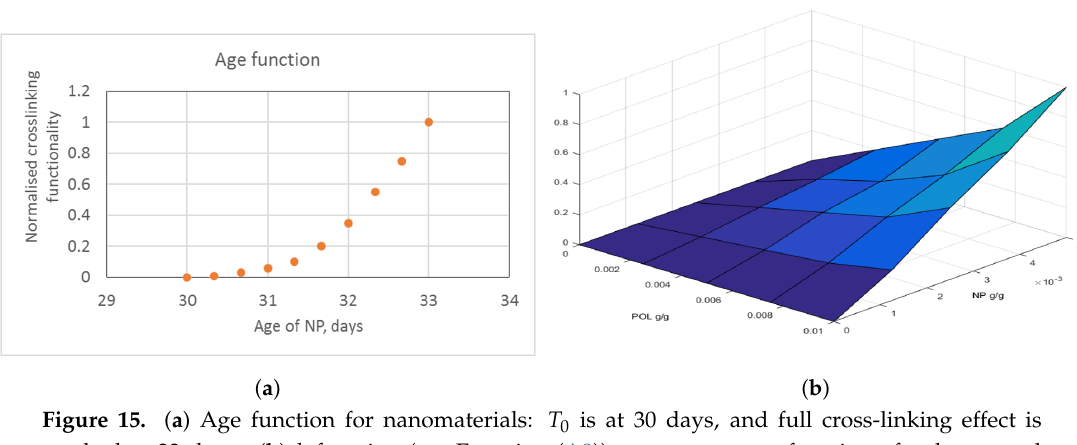
Figure 15. ( a ) Age function for nanomaterials: T 0 is at 30 days, and full cross-linking effect is reached at 33 days. ( b ) h -function (see Equation (A9)): two parameter function of polymer and nanomaterial